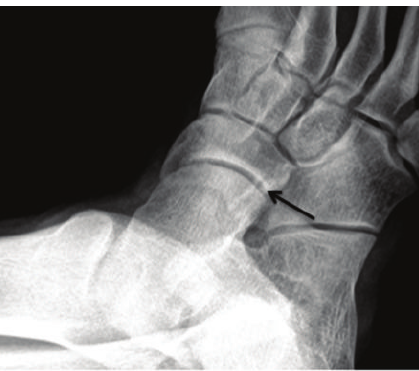
Figure 1: Magnified oblique radiograph of the right foot in a 17-year-old male better delineates the abnormal articulation between the cuboid (arrow) and the navicular.